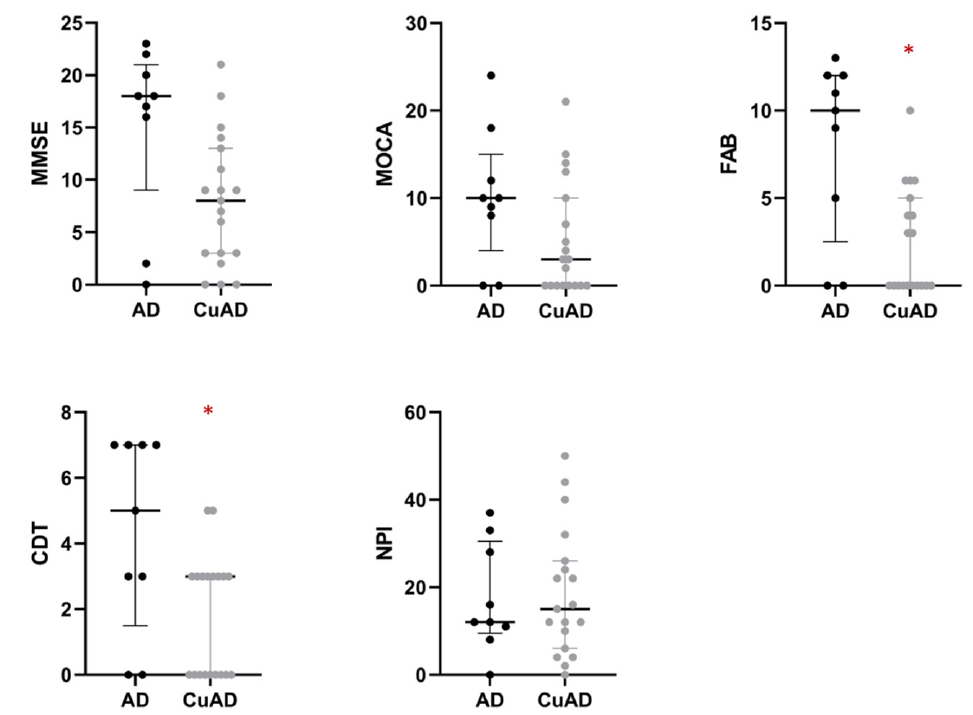
Figure 2. Comparison of AD and CuAD neuropsychological test battery. Data are mean and standard deviation. Raw data are shown, not adjusted for subjects’ differences in sex and age. AD: AD subjects with non-Cp Cu ≤ 1.6 µ mol/L (black circles). CuAD: AD subjects with non-Cp Cu > 1.6 µ